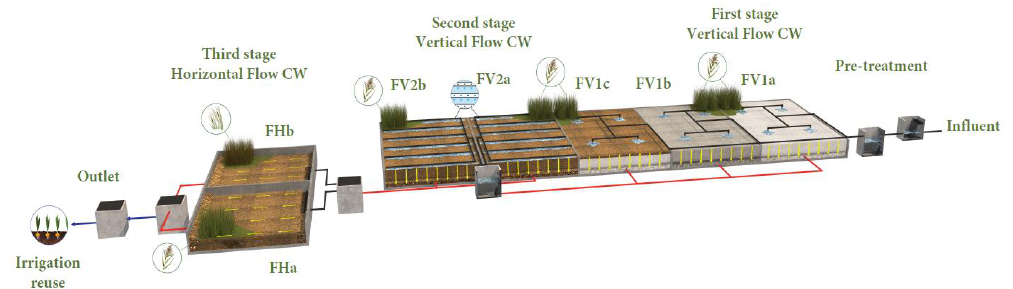
Figure1. Figure 1. Multistage constructed wetland (CW) layout (prototype, University Gaston Berger (UGB) campus).